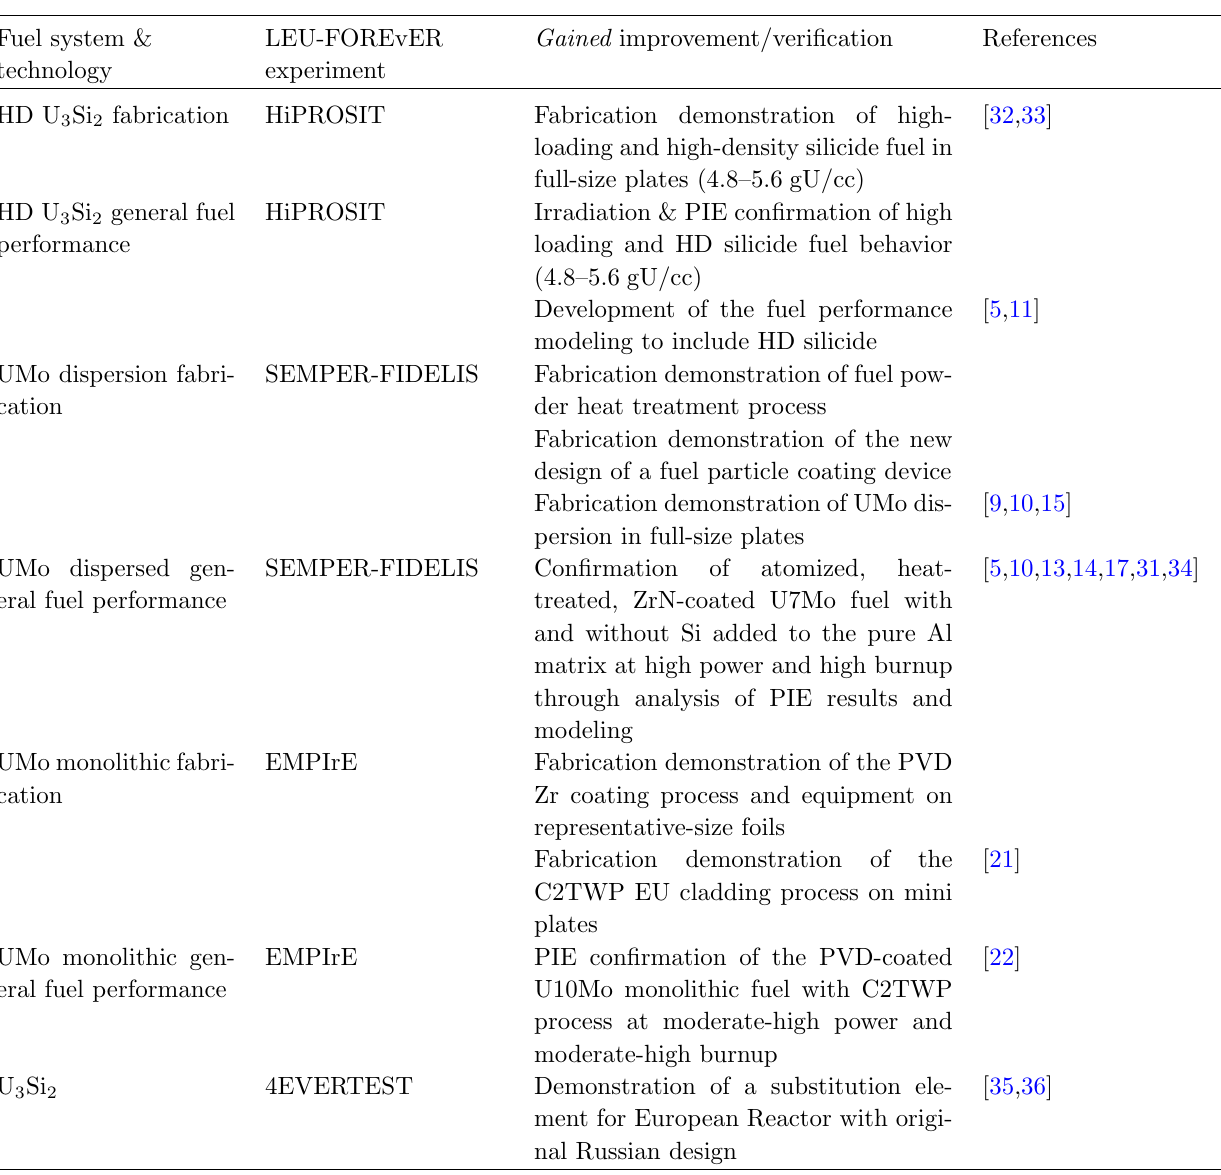
Table 2. LEU-FOREvER targeted fabrication technologies and verification experiments for specific fuel systems and gained verification of specific